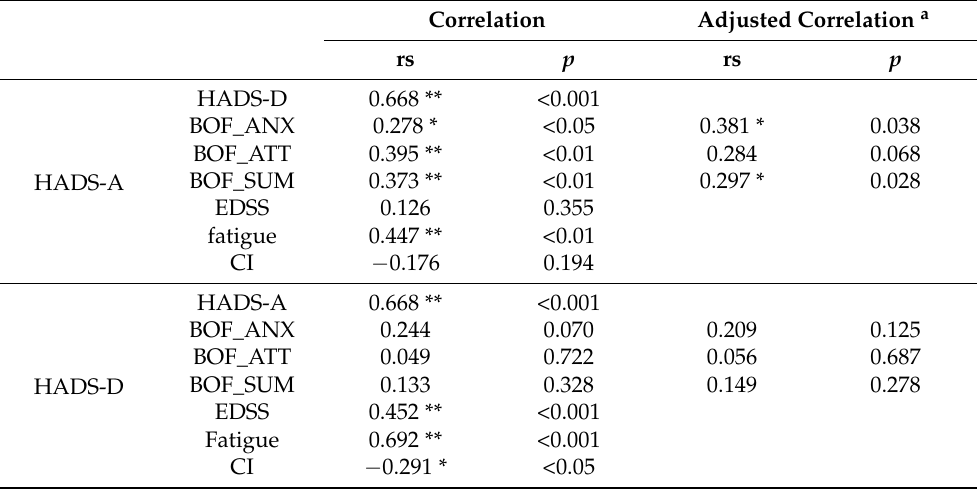
Table 4. Spearman bivariate correlation and partial correlation of the BOFRETTA 2.0 with group differences between anxious and non-anxious as well as depressive and non-depressive patients (N =